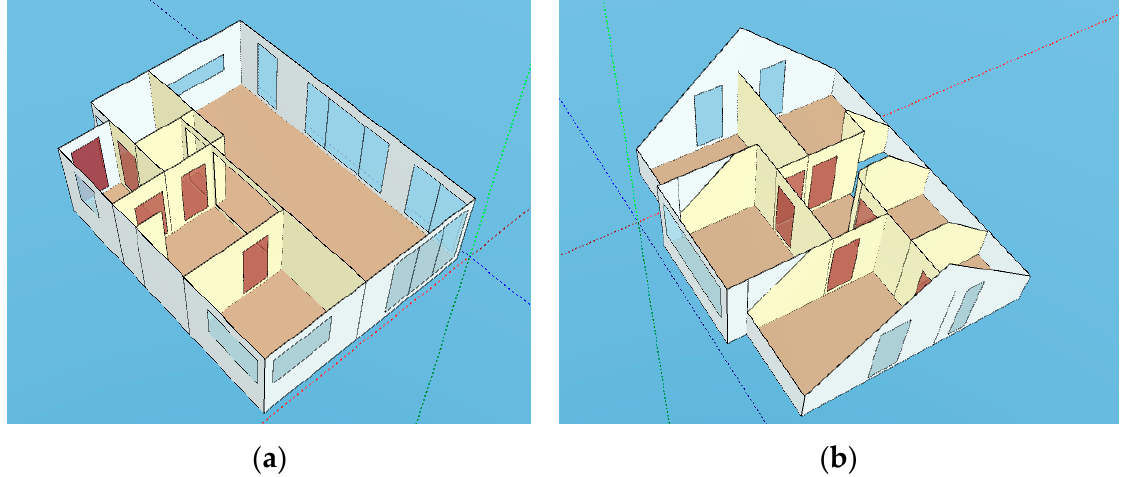
Figure 2. An axonometric projection of the building consignations: ( a ) ground floor; and ( b ) attic in the Audytor OZC software [25].